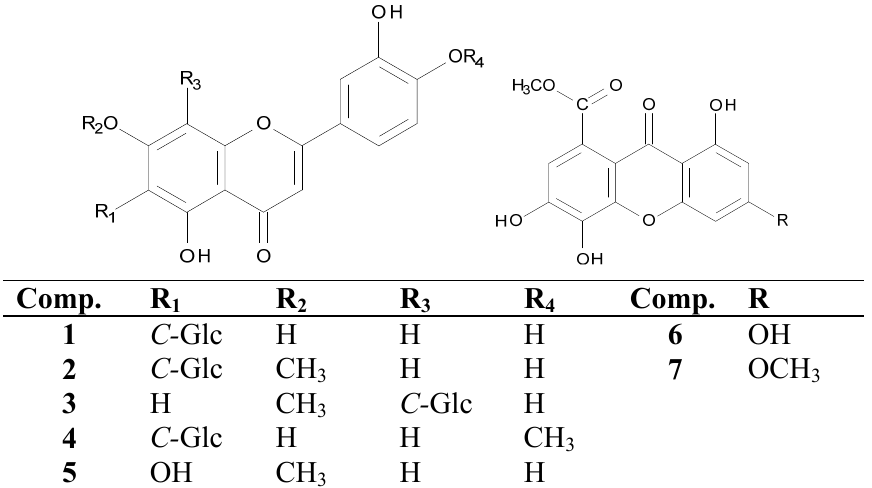
Figure 1. Compounds isolated from the MeOH extract of leaves of L. spiralis